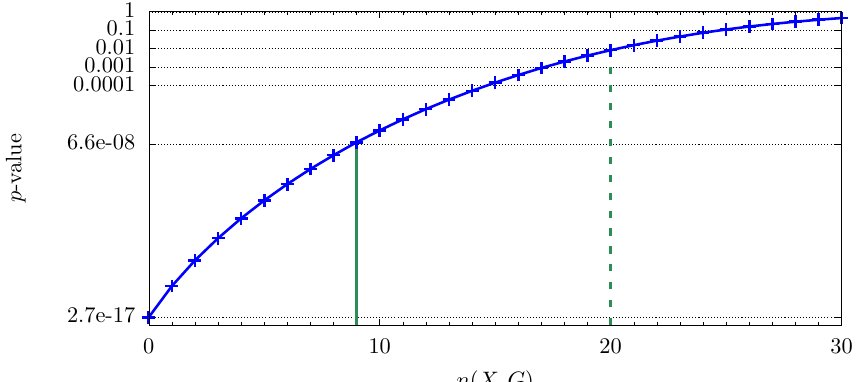
Figure 4. The behaviour of the p -value of a pattern X under different support counts n ( X , G ) , assuming marginal counts n ( X ) = 184, n ( G ) = 167, and N = 987 (see example in Figure 1, group-level analysis, third row, attribute value